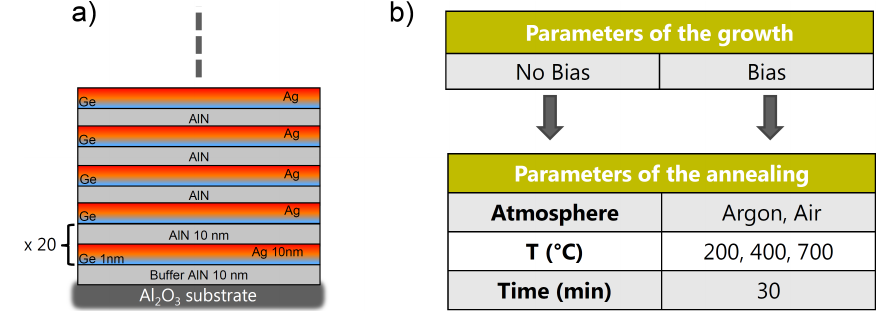
Figure 1. ( a ) schematic representation of the Ag[Ge]/AlN NMLs studied and ( b ) the parameters changed during deposition and subsequent thermal